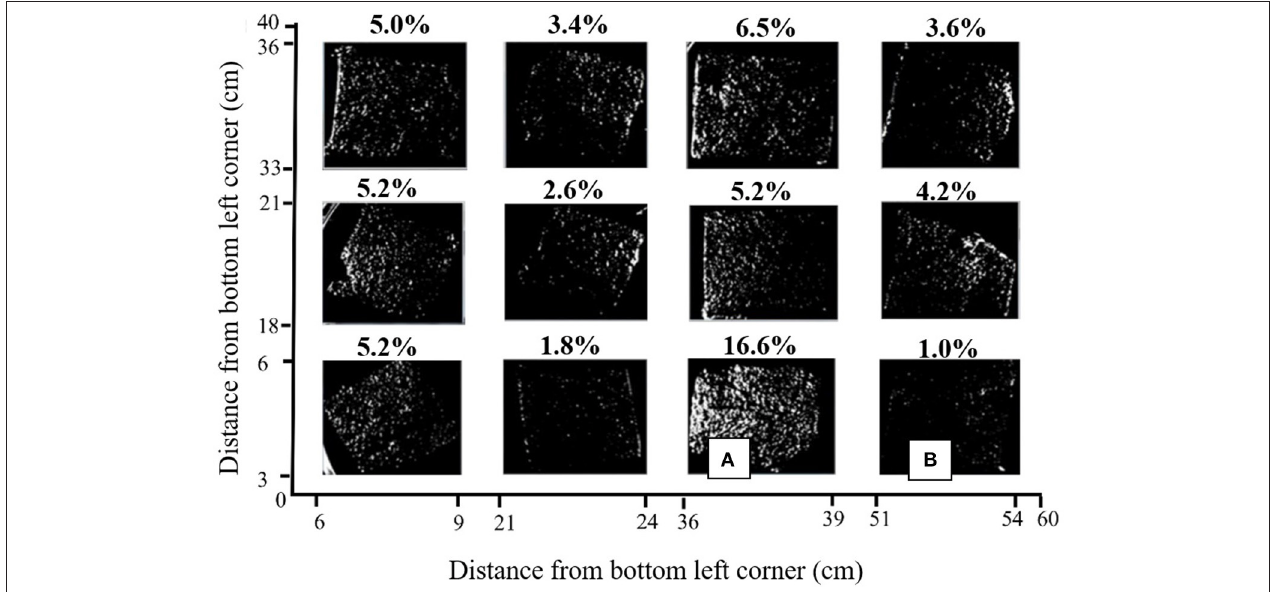
FIGURE 4 | Binary image of SYBR gold stained anode from MEC2 visualized in an iBOX UVP gel documentation system under UV light at 340nm. Axes indicate the positioning of each sample on the original 40 × 60cm anode surface. The percentage of sample which was fluorescent is shown above each square. (A) , The sample with the highest percentage of visible fluorescent stain, at 16.6%, (B) , The sample with the lowest percentage of visible fluorescent stain at